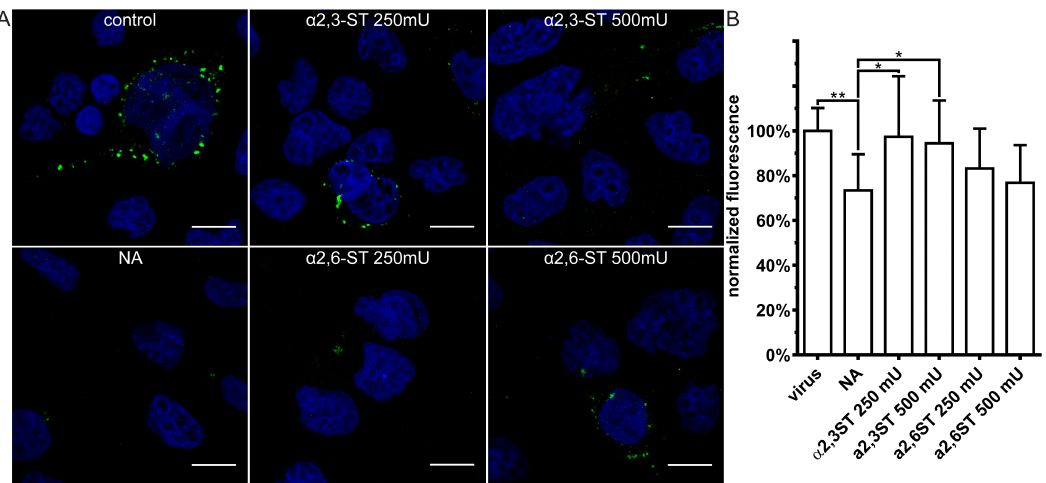
Figure 7. Resialylation restores CRCoV attachment to SAs-depleted cells. Cells treated with type II neuraminidase (NA, 500 mU/mL) and overlaid with α -2,3-sialyltransferase ( α 2,3-ST) or α -2,6-sialyltransferase ( α 2,6-ST) in the presence of 1 mM cytidine-5 (cid:48) -monophospho- N -acetylneuraminic acid for 2 h at 37 ◦ C. Next, cells were overlaid with iodixanol-concentrated CRCoV, incubated for 2 h at 4 ◦ C, fixed and immunostained. ( A ) Confocal analysis of CRCoV attachment in presence of NA and STs. Virions are presented in green, while blue denotes DNA. Scale bar 10 µ m. Data were collected from a minimum of 12 fields of view, from at least two different samples. ( B ) FACS analysis of viral attachment in presence of NA and STs. Graph shows median fluorescence normalized to control. All data is presented as mean ± SD from at least three experiments in triplicates. (* p < 0.05; ** p < 0.01; *** p < 0.001; **** p < 0.0001).